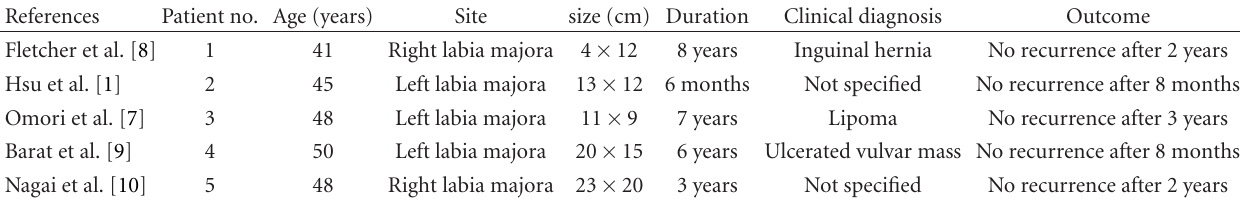
Table 1: Clinical features of pedunculated AMFB of the vulva.